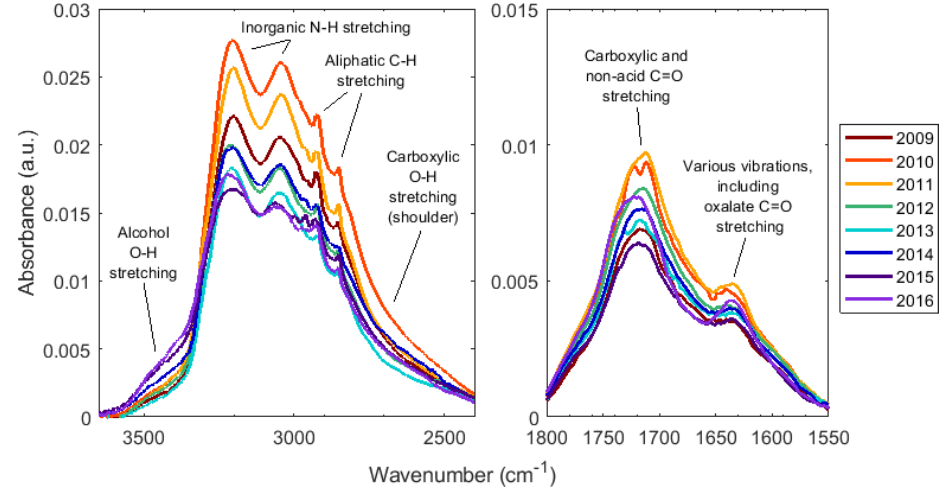
Figure 4. Annual median baseline corrected spectra of samples collected at JST. Colored lines, as indicated in the legend, demonstrate a progression of absorbance over time. For baseline correction and blank spectrum subtraction details, see Sect.